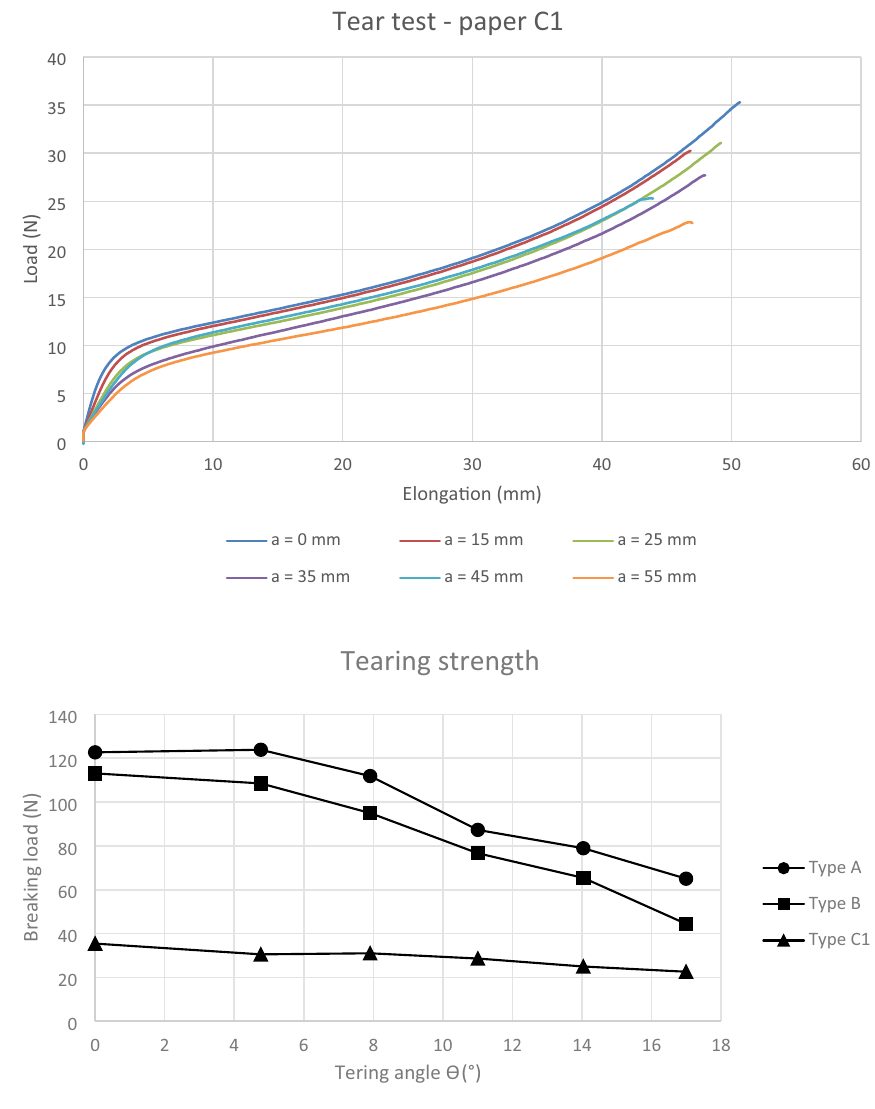
Fig. 12 Tear test curves of paper C1 per misalignment